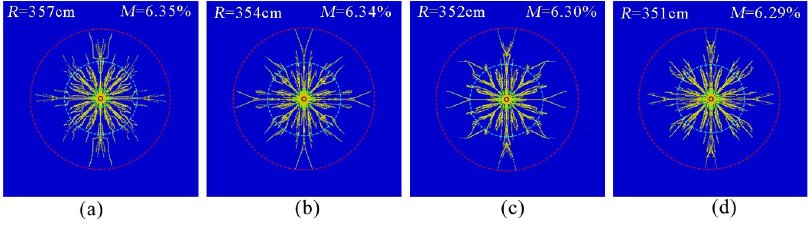
Fig 8. Crack distribution at different tensile strengths. (a)Tensile strength 0.2 MPa.(b)Tensile strength 0.5 MPa.(c) Tensile strength 0.8 MPa (d)Tensile strength 1.1 MPa.